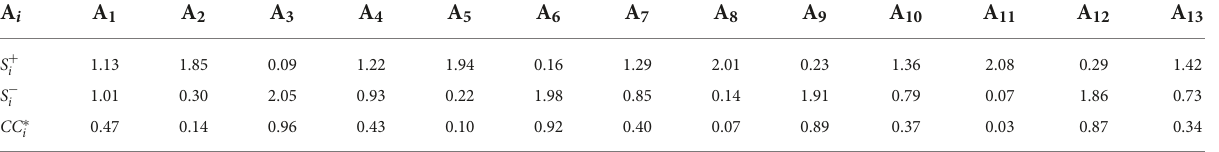
TABLE 10 Coefficient closeness of each